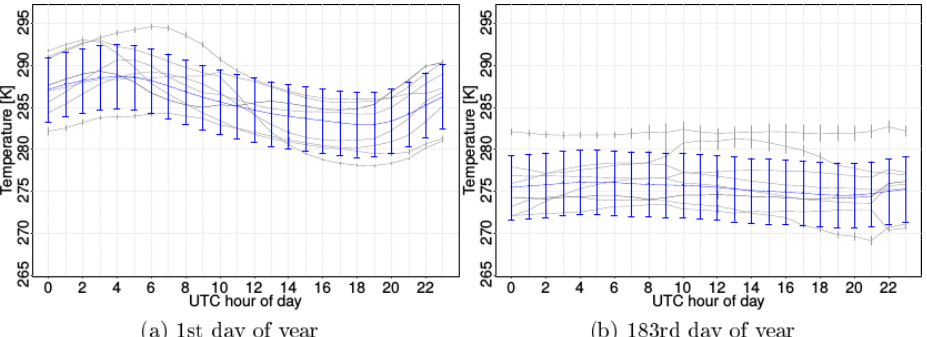
Figure 2. Fitted diurnal cycle (blue) and ERA5 temperatures for 2 example days of the year from 2010 to 2016 (grey), at 925hPa above Lauder. The ERA5 ensemble standard deviation is shown as vertical bars around the grey lines and the uncertainty on the fitted diurnal cycle is shown in the blue error